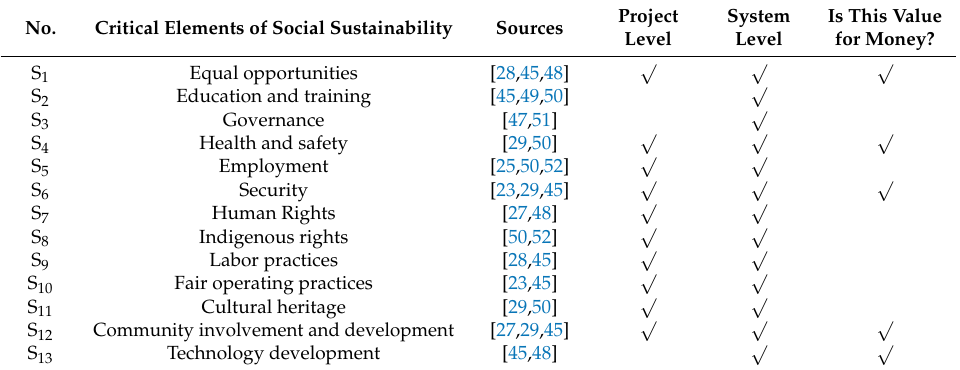
Table 2. Critical elements of social